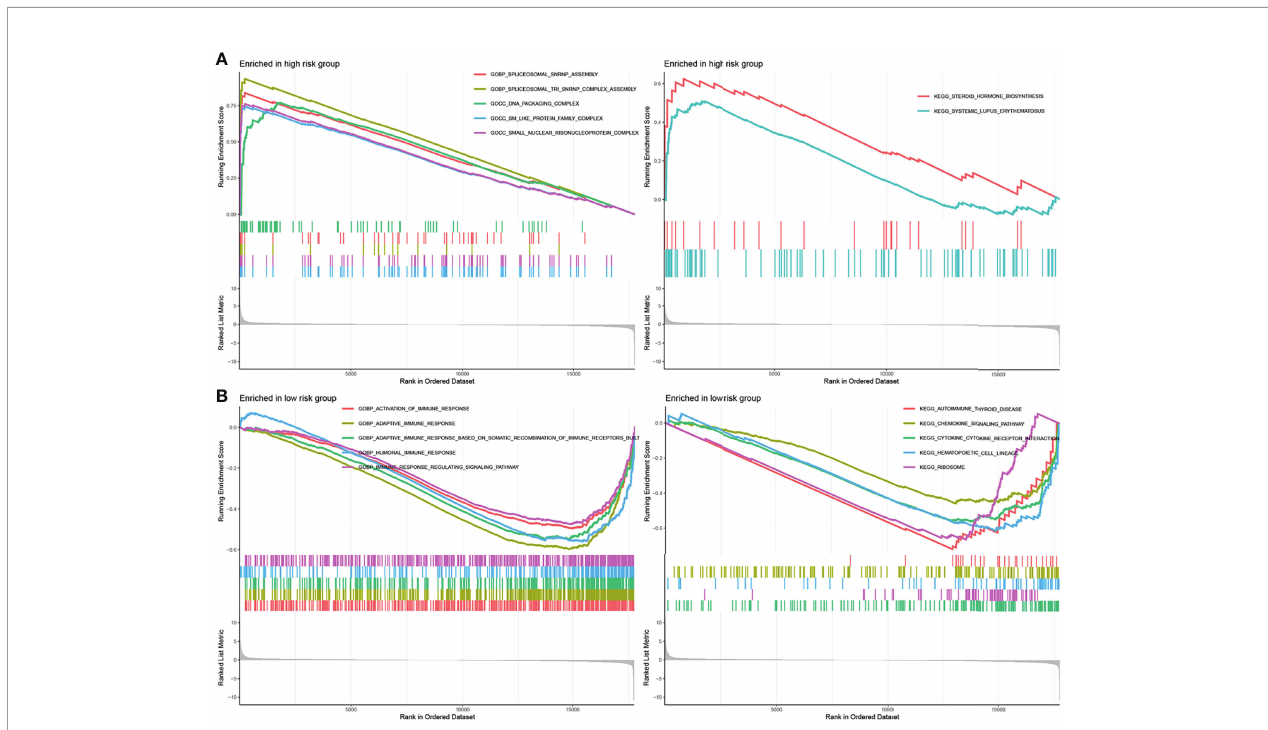
FIGURE 5 | GSEA analysis of different IRGPI subgroups. (A) GSEA enriched in high-IRGPI subgroup. (B) GSEA enriched in low-IRGPI subgroup. ( P <